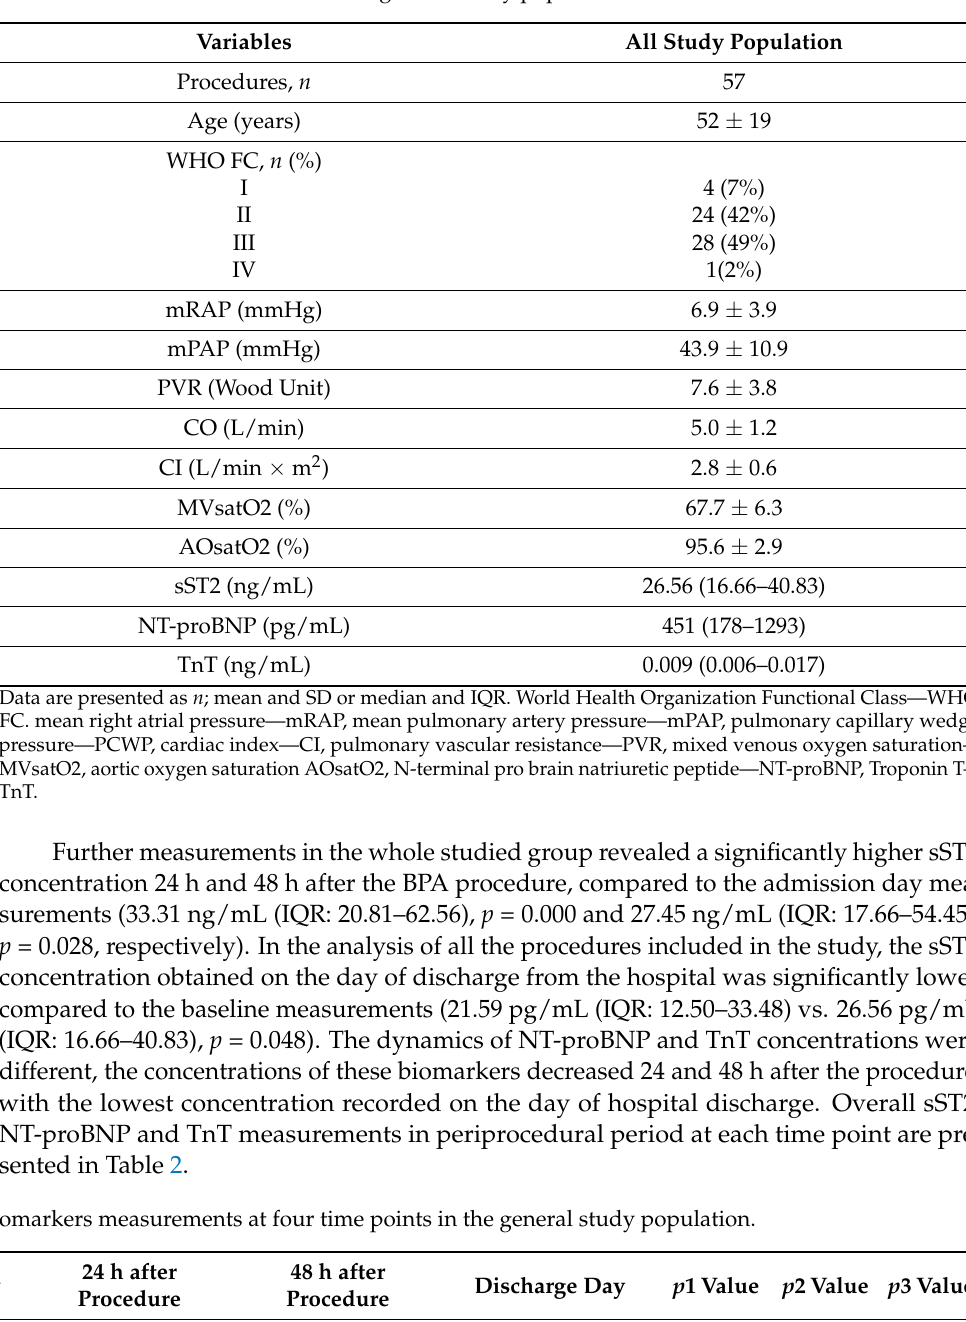
Table 1. Baseline characteristics of the general study population.